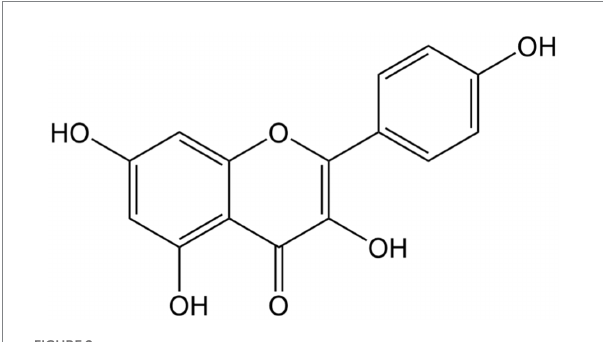
FIGURE 2 Chemical structure of kaempferol.